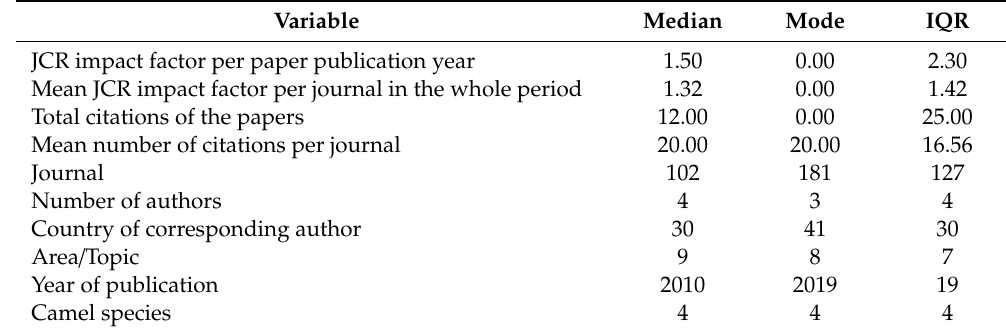
Table 2. Mean, mode and interquartile range (IQR) for the variables of Journal Citation Report (JCR) impact factor per paper publication year, mean JCR impact factor per journal during the whole period, total citations of the paper, mean number of citations per journal and predictors in the model